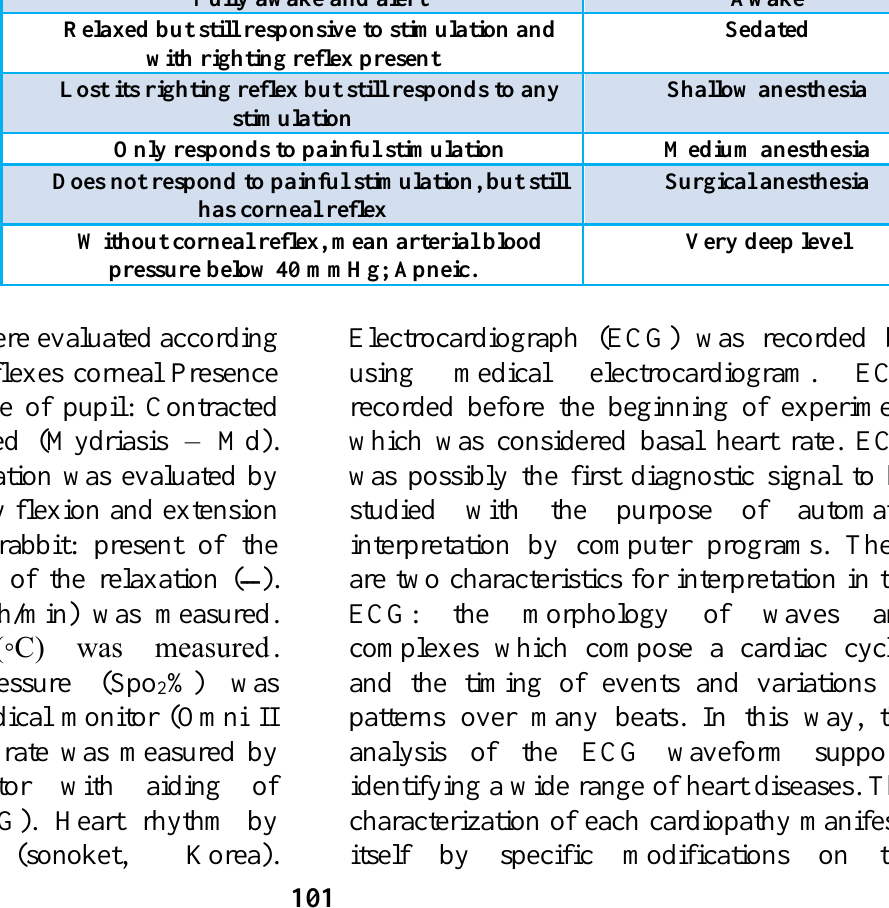
Table, 1: Depth of anesthesia based on the clinical signs and the respective attributed numerical scale. Numerical scale of Clinical signs Anesthetic state anesthesia Fully awake and alert Awake Relaxed but still responsive to stimulation and with righting reflex present Lost its righting reflex but still responds to any stimulation 3 Only responds to painful stimulation Medium anesthesia 4 Does not respond to painful stimulation, but still has corneal reflex 5 Without corneal reflex, mean arterial blood pressure below 40 mmHg; Apneic.